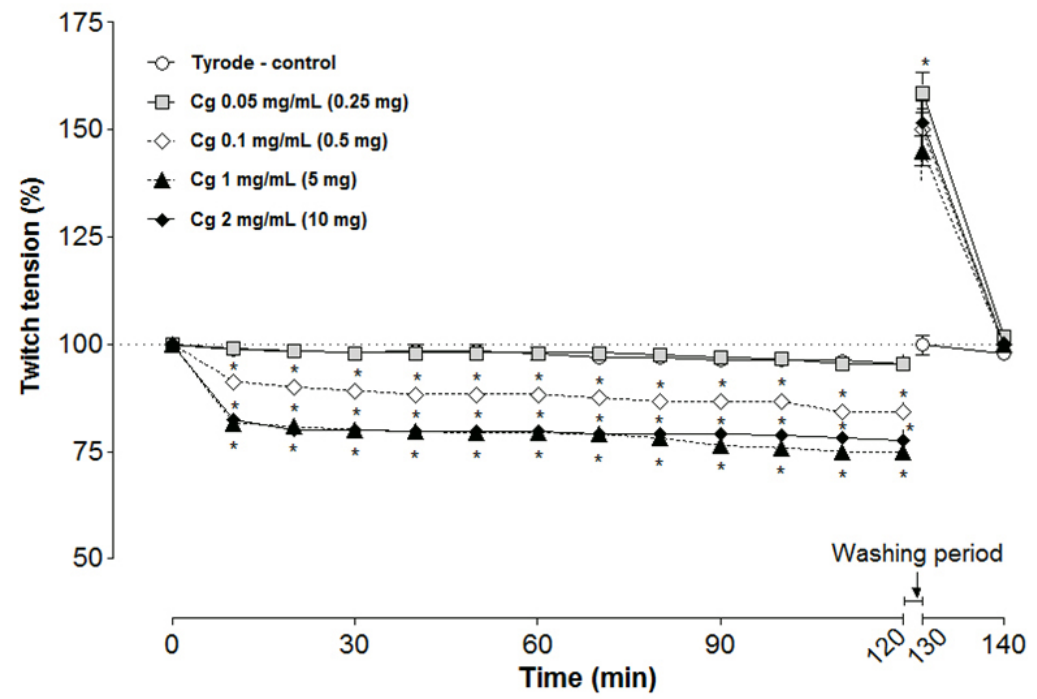
Figure 2. Twitch tension of mouse isolated phrenic nerve-diaphragm preparations under indirect stimuli, in percentage (each point represents the mean ± SEM, n = 6). Action of Cg hydroalcoholic extracts at concentrations of 0.05, 0.1, 1 and 2 mg/mL (or 0.25, 0.5, 5 and 10 mg, respectively). All extract concentration, except the first one, significantly differed from that of Tyrode solution (control) during 120 minutes (* p < 0.05).